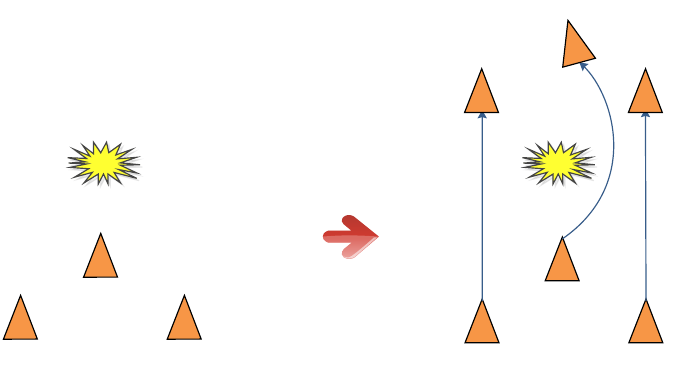
Figure 5. Simulation scenario: a team of three robots.